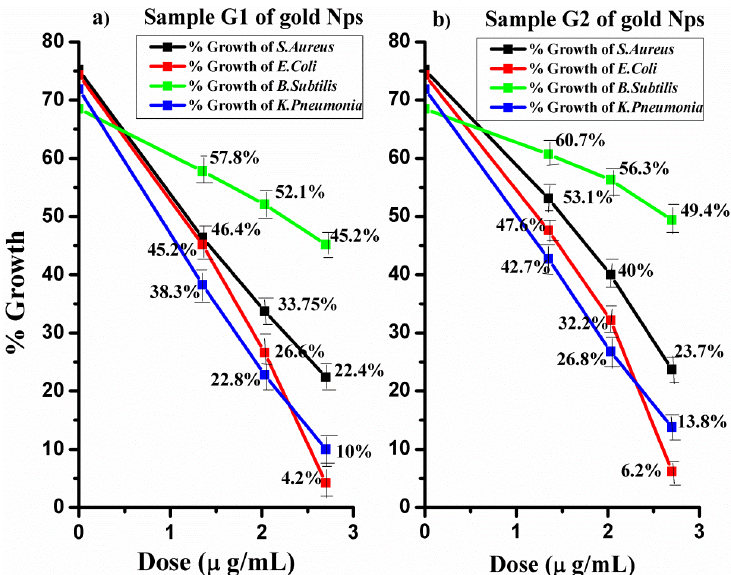
Figure 4. ( a ) Percent growth of S. aureus , B. subtilis , E. coli , and K. pneumonia by G1 of gold NPs; ( b ) Percent growth of S. aureus , B. subtilis , E. coli and K. pneumonia by G2 of gold NPs.